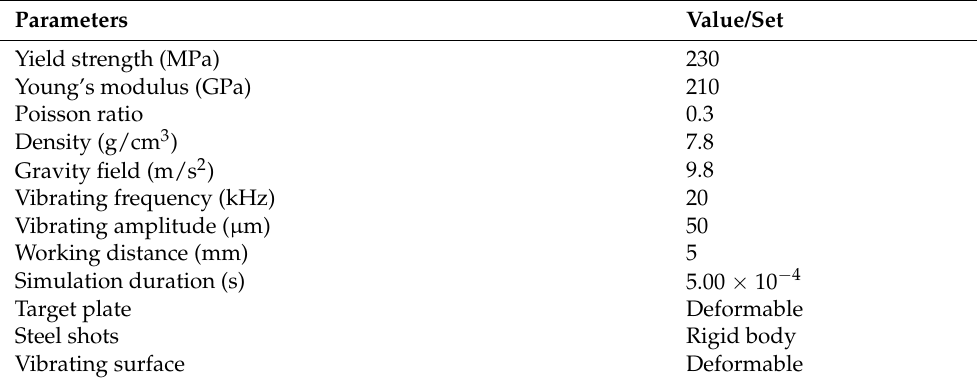
Table 1. The key parameters for the FE simulation of the ultrasonic shot peening process with a single